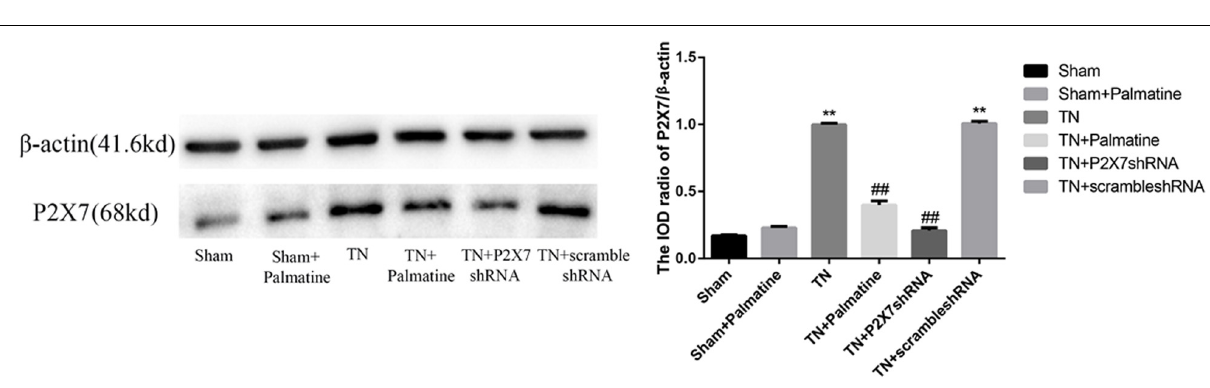
FIGURE 6 | Effects of palmatine on the expression of the P2X7 receptor in TGs of each group on day 15 postoperation assessed by Western blotting. Values are mean ± SD, n = 6, ** p < 0.01 vs. sham group, ## p < 0.01 vs. TN